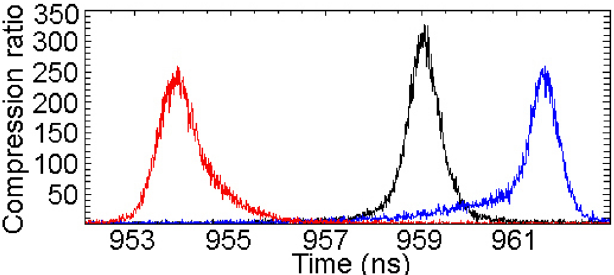
(cid:2) t (cid:3) =I FIG. 21. (Color) Compression ratio I comparison in the b 0 with linear increase or decrease by laboratory frame of initial E 0 (cid:4) 300 ns , using the smooth wave- (cid:13) 2% over the pertinent t p form across the finite-size gap, for T k (cid:4) 0 : 2 eV beams with (cid:2) t (cid:3) (cid:4) 400 – 408 keV (red) at z (cid:4) (cid:8) 59 : 3 cm , constant rising E 0 (cid:2) t (cid:3) (cid:4) 400 keV (black) at z (cid:4) (cid:8) 59 : 5 cm , and sinking E (cid:2) t (cid:3) (cid:4) E 0 0 400 – 392 keV (dark blue) at z (cid:4) (cid:8) 59 : 3 cm .